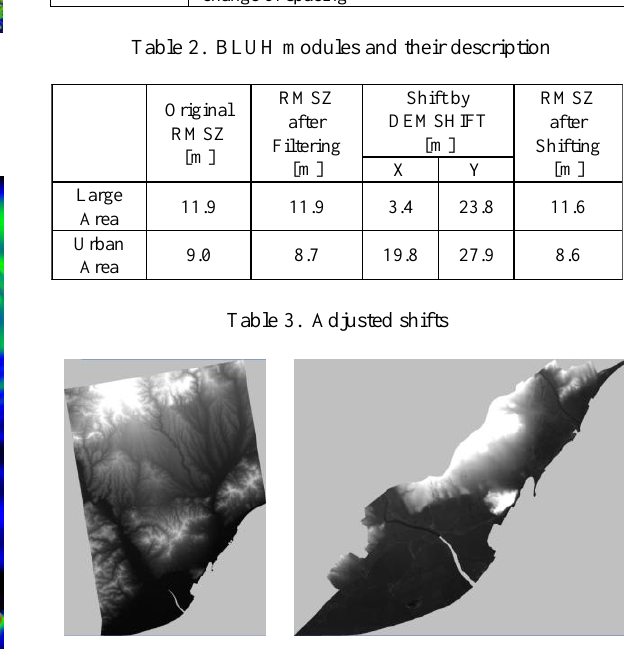
Figure 5. Interferogram after WFF